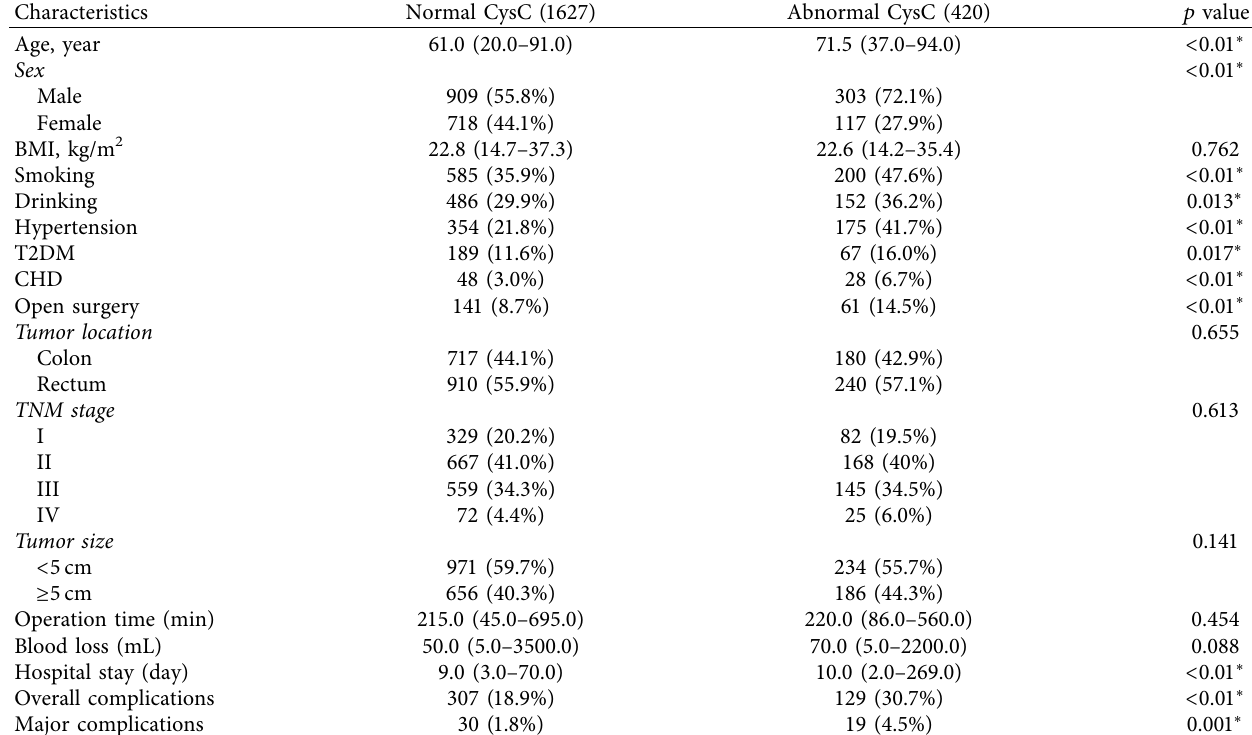
Table 3: Comparison between the normal CysC group and the abnormal CysC group.